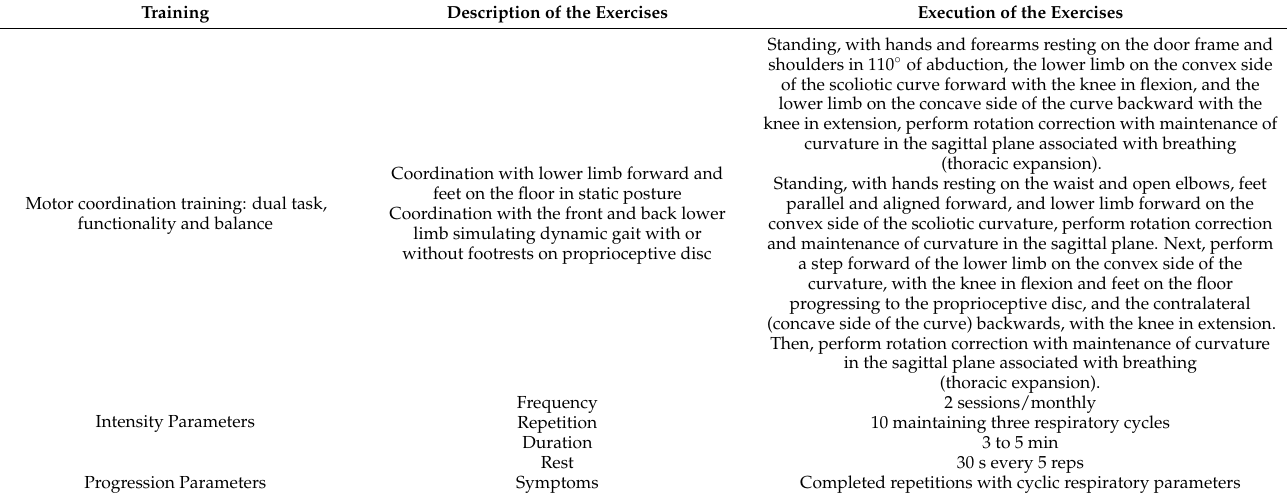
Table 3. Intervention protocol with specific motor coordination exercises: dual task, functionality, and balance for adolescents with idiopathic scoliosis